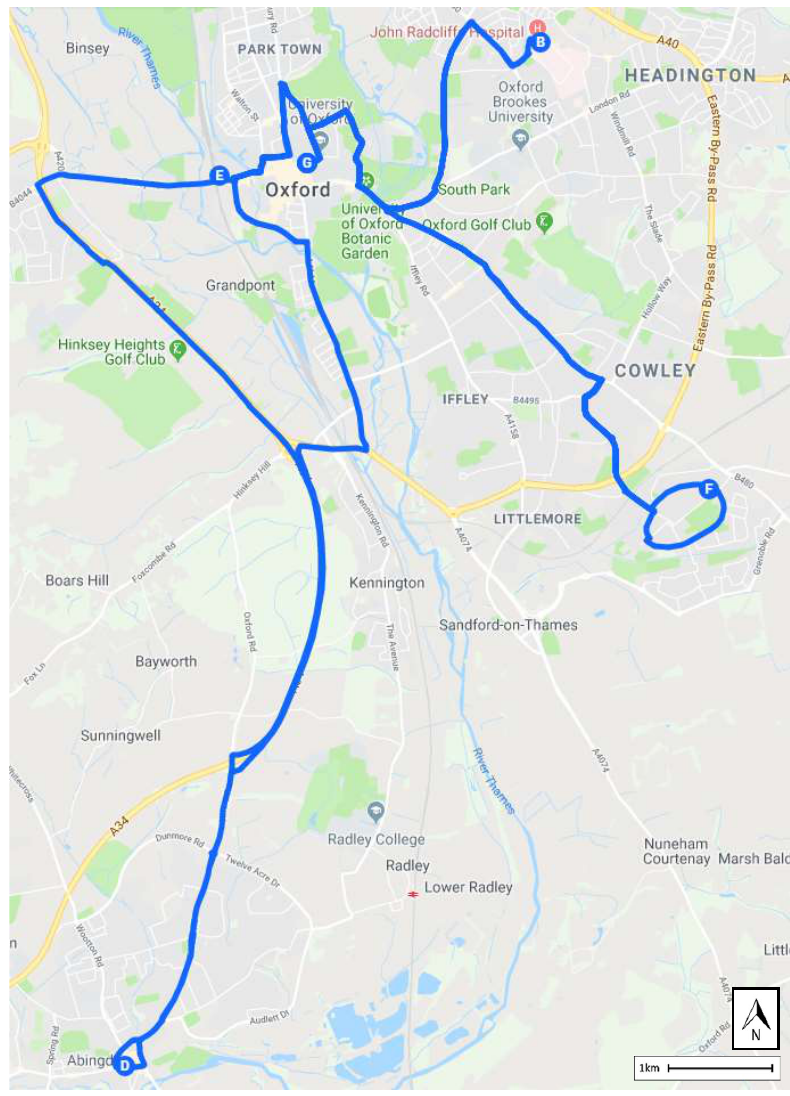
Figure 7. Route taken by Euro 5 diesel car (map data © Google).